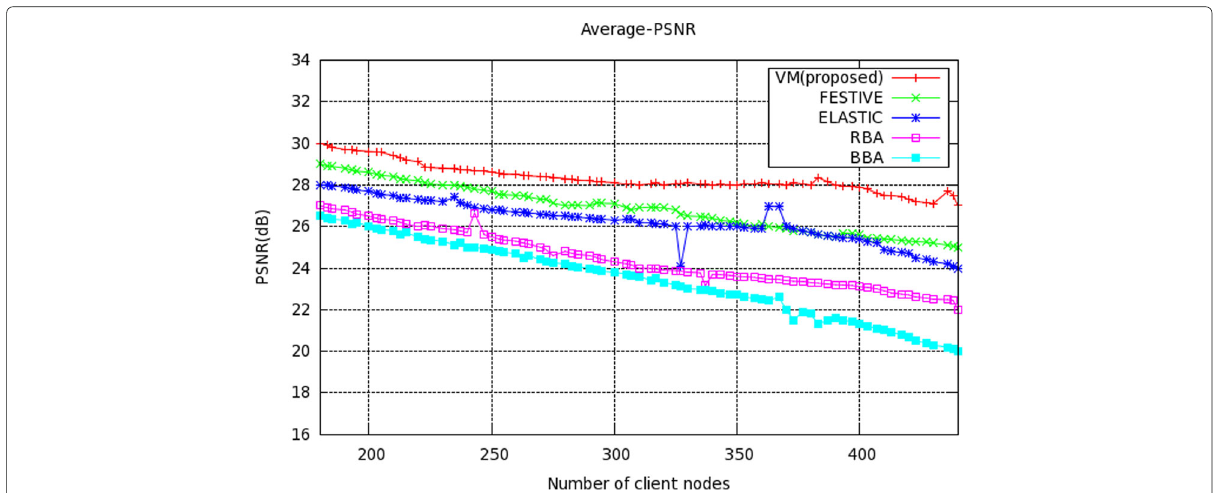
Fig. 3 Average PSNR of buffer management